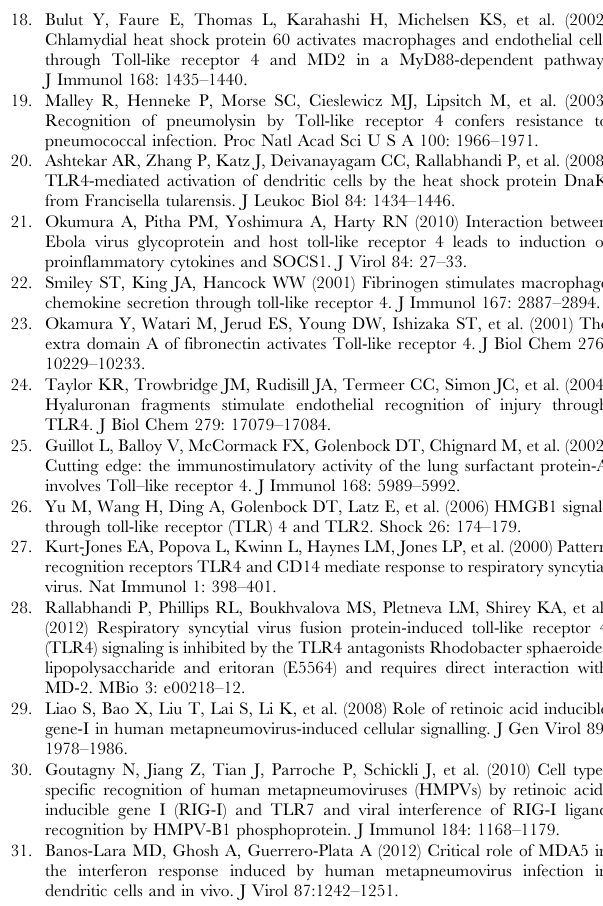
Figure S1 Body weight loss and cytokines/chemokine secretion in response to UV-inactivated hMPV. WT mice were either infected with hMPV or UV-inactivated hMPV or mock infected. Change in body weight was measured over a period of 12 days and is expressed as percentage of baseline weight ( A ). Levels of IL-1 a , IL-6, TNF- a , G-CSF, IL-12 p(40), IL-17, Eotaxin, MCP-1, MIP-1 b fluid were measured in BAL fluid on day 1 p.i. ( B ). Data are expressed as mean 6 SEM of four